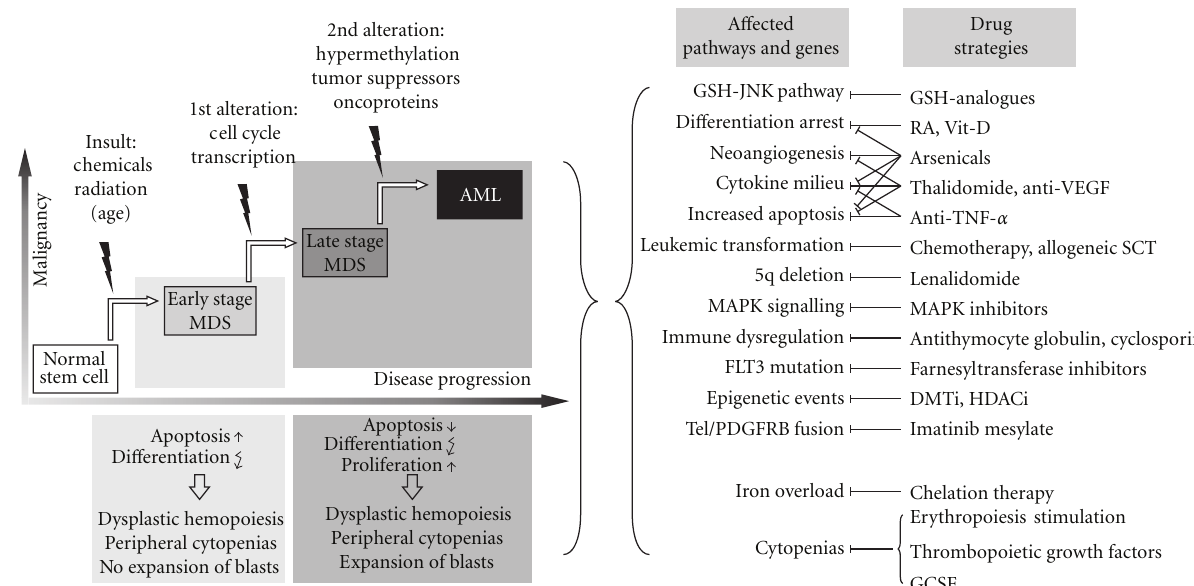
Figure 1: Pathophysiological mechanisms involved in MDS and points of action for possible therapy approaches. Abbreviations: AML: acute myeloid leukaemia; GCSF: granulocyte colony-stimulating factor; GSH: glutathione; MAPK: mitogen-activated protein kinase; MDS: myelodysplastic syndrome; PDGFR: platelet-derived growth factor receptor; RA: retinoic acid; SCT: stem cell transplantation; TNF: tumour necrosis factor; VEGF: vascular-endothelial growth